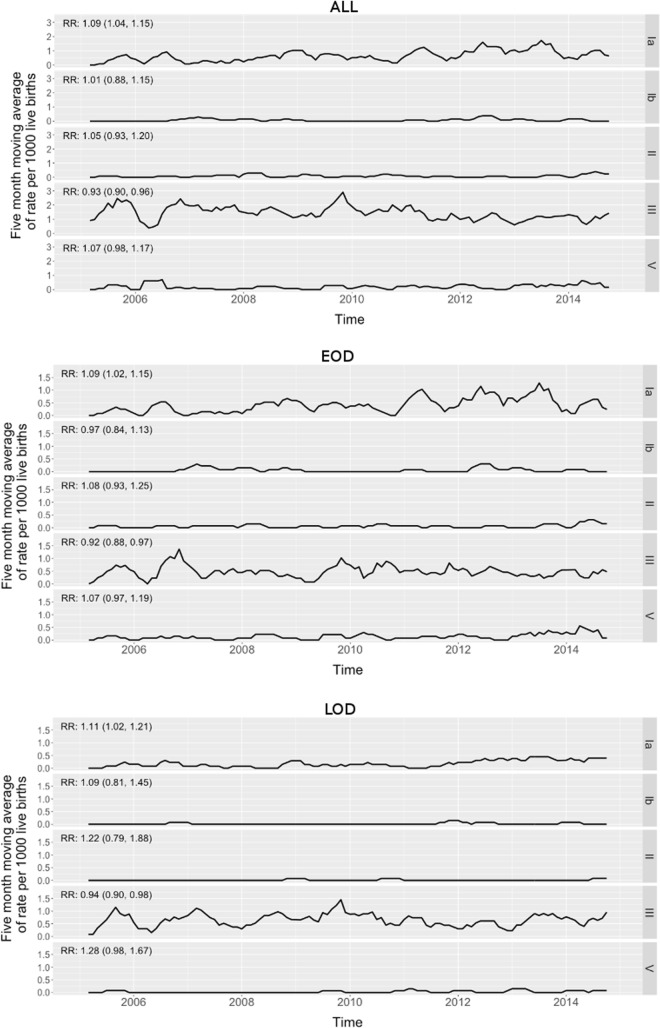
Five-term moving average and year-on-year relative risk (RR; 95% confidence interval) of serotype-specific incidence rates of invasive GBS disease for All (A), early-onset disease (B) and late-onset disease (C).